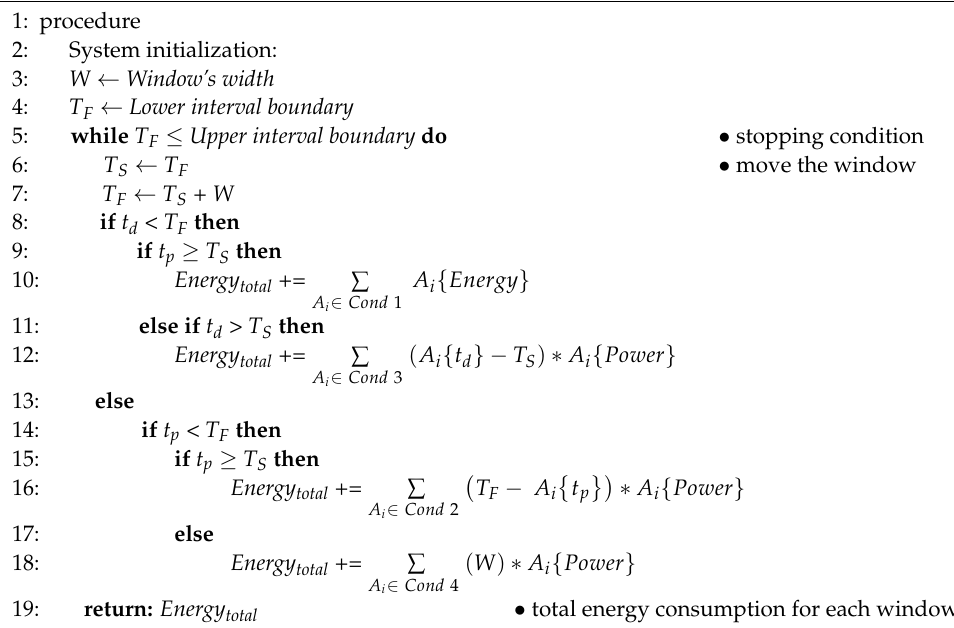
Algorithm 1: Calculating total energy consumption in tuned window width in the coveted